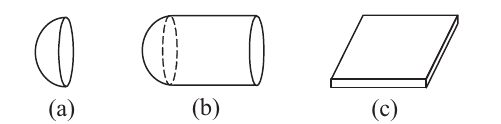
Fig. 3. Fragment distribution.